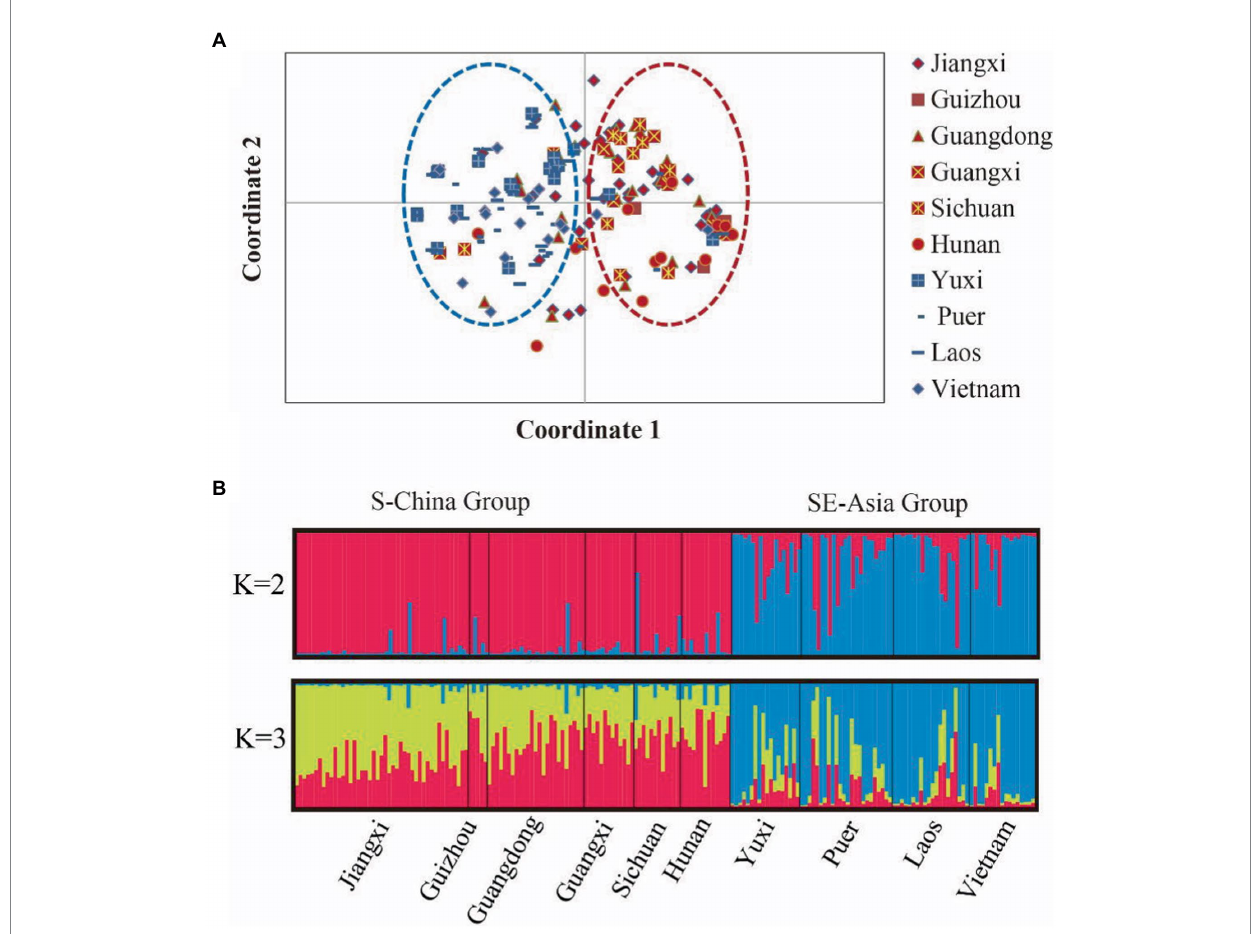
FIGURE 4 The genetic structure within 10 populations of the bamboo grasshopper. (A) Principal coordinates analysis of the 10 populations. Population codes are listed in Supplementary Table S1. (B) Bayesian assignment proportions for K = 2 and K = 3 clusters determined in STRUCTURE